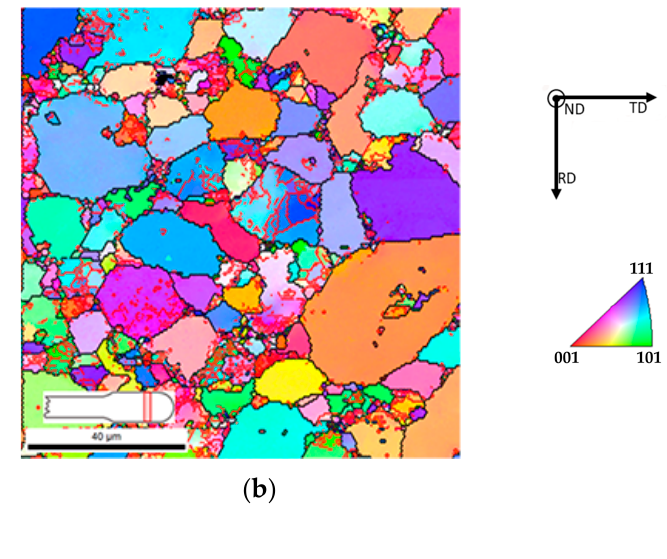
( h ) Figure 15. ( a , b ) IPF maps, with high-angle (black) and low-angle (red) boundaries, ( c , d ) IPFs, ( e , f ) GNDs density and ( g , h ) Al and Al/CNT samples at the head of the tensile samples.